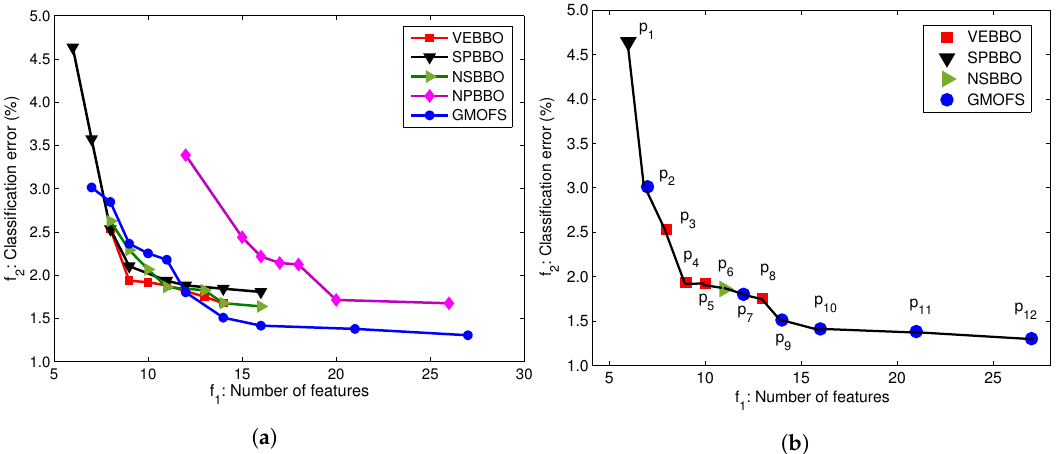
Figure 8. ( a ) Pareto fronts obtained from MOO methods with an SVM classifier with linear kernels using AB01 training data; ( b ) combined Pareto front obtained from non-dominated Pareto points in ( a ). Table 4. Comparison of Pareto fronts using relative coverage (RC). Only 7.2% and 30% of the VEBBO and GMOFS points, respectively, are dominated by other Pareto points; so VEBBO and GMOFS rank first and second, respectively, in terms of RC.